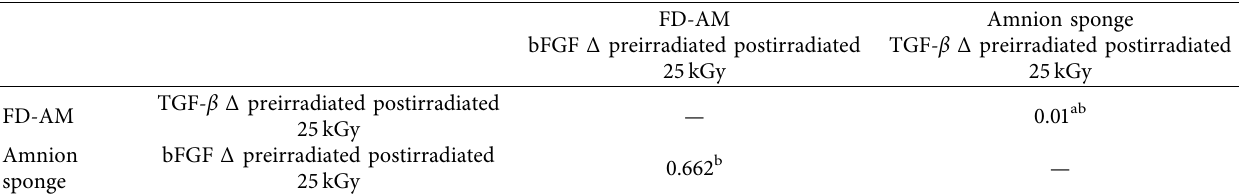
FD-AM Amnion sponge bFGF Δ preirradiated postirradiated TGF- β Δ preirradiated postirradiated 25kGy